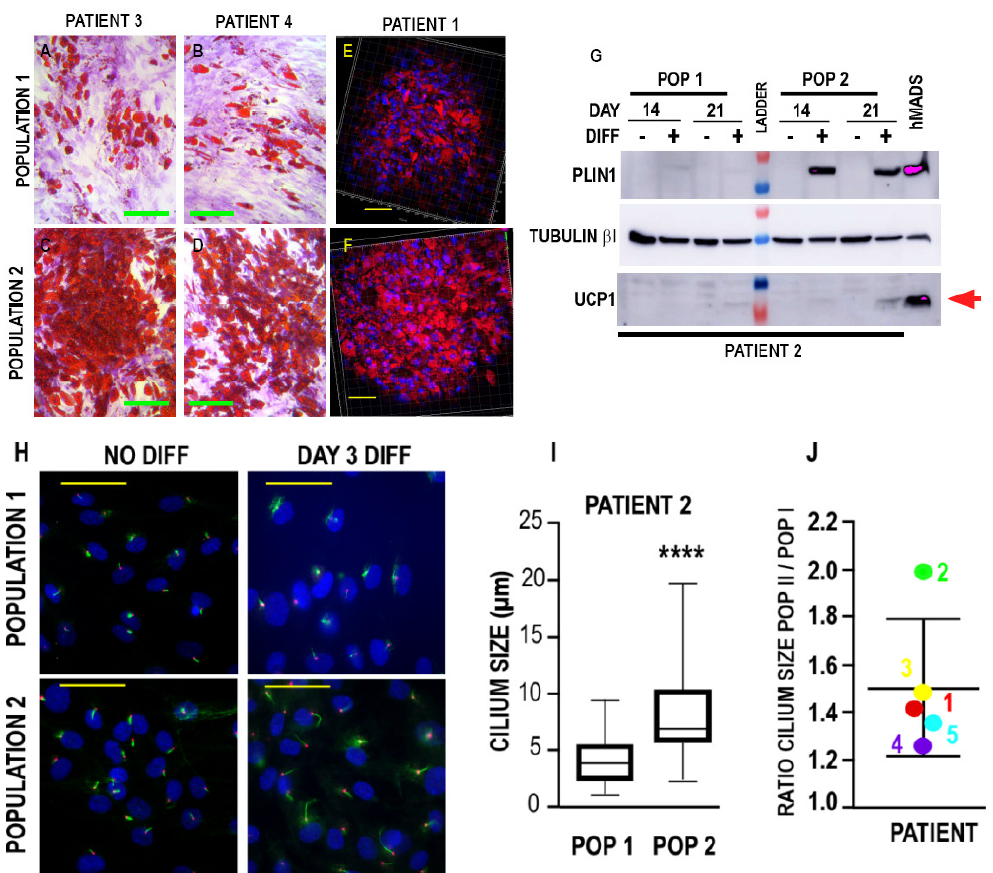
Figure 2. Adipose differentiation of the two breast adipose progenitor cell (APC) populations. ( A – D ) Breast APCs were cultured in differentiation medium for 15 days. Differentiation was assessed by Oil-Red-O staining. Crystal Violet was used to counterstain the population that was not differentiated. Magnification ×20; scale bar, 100 µM. ( E , F ) APCs were grown and differentiated in 3 dimensions. Oil-Red-O staining revealed that the number of lipid-laden cells is lower in Population 1. DAPI marks the nuclei of the cells. Scale bar, 50 µM. ( G ) Protein expression was measured in breast APCs grown in differentiation medium for 14 or 21 days. Expressions of PLIN1 (upper panel), Tubulin-βI used as a loading control (intermediate panel), and of UCP1 (lower panel) were analyzed by Western blot, using specific antibodies. Representative Western blots are shown. ( H ) Cells were fixed, and acetylated tubulin (green) and pericentrin (red) were revealed by immunocytochemistry; nuclei were stained with Hoechst 33,258 (blue). The yellow scale bar represents 50 µm. ( I ) Quantification of the cilium size of the different populations after 3 days of differentiation. One hundred cilia were measured by using image J for each condition. A box plot of the results for Patient 1 is presented (**** p < 0.0001, unpaired t -test). ( J ) The ratio of the cilium length of Populations 2 and 1 after 3 days of differentiation is provided for each patient. For each condition, a minimum of 100 cilia were